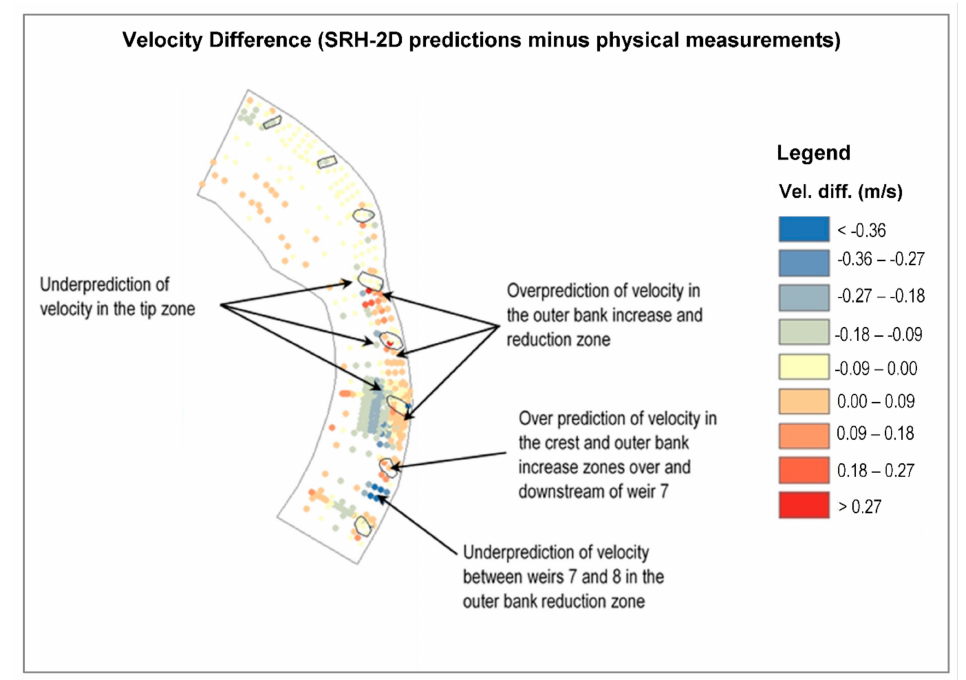
Figure 24. Bendway weir configuration BW02: difference between measured and predicted values of